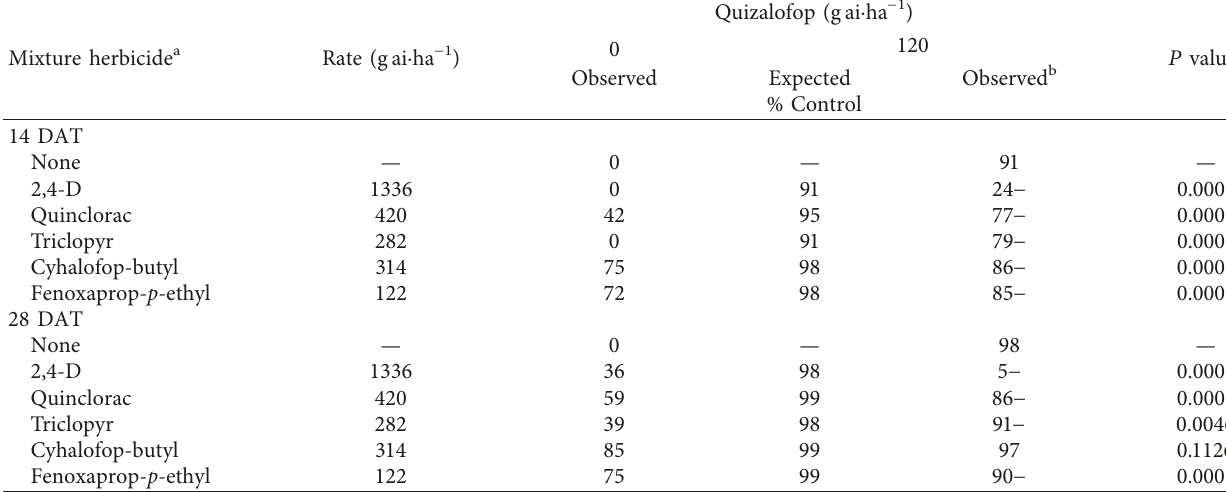
Table 2: Barnyardgrass control with quizalofop- p -ethyl mixed with different synthetic auxin or ACCase-inhibiting herbicides in 2015 and 2016 crop seasons.